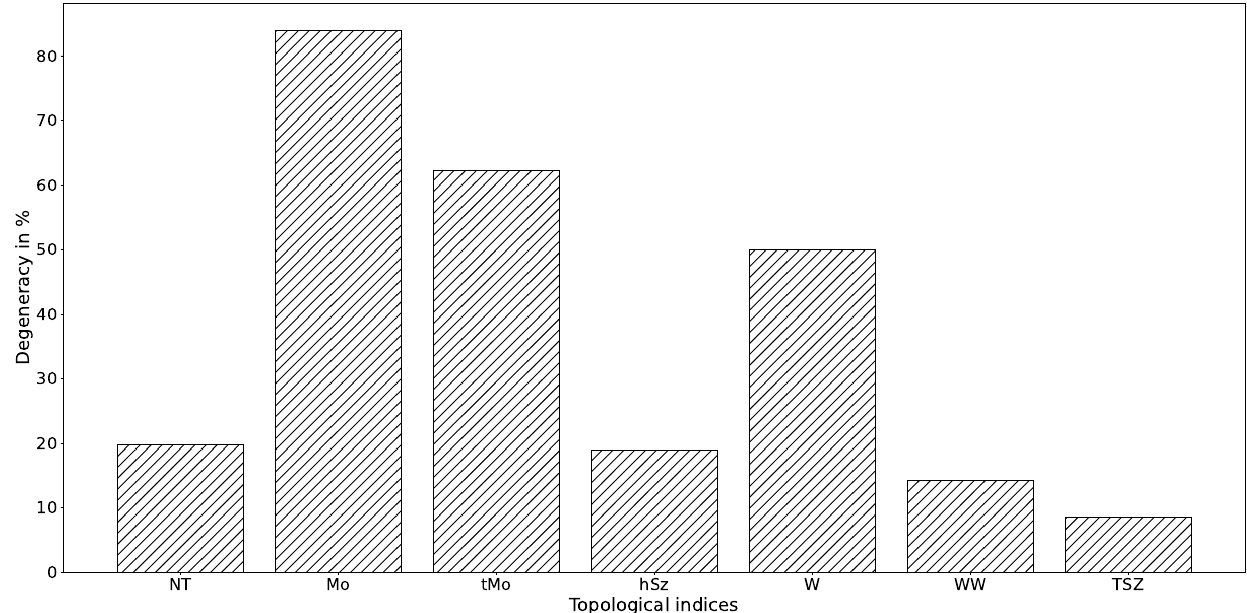
Figure 3: The levels of degeneracies of Trinajsti´c ( NT ), Mostar ( Mo ), total-Mostar ( tMo ), hyper-Szeged index ( hSz ), Wiener ( W ), hyper-Wiener ( WW ), Tratch-Stankevich-Zefirov ( TSZ ) indices.